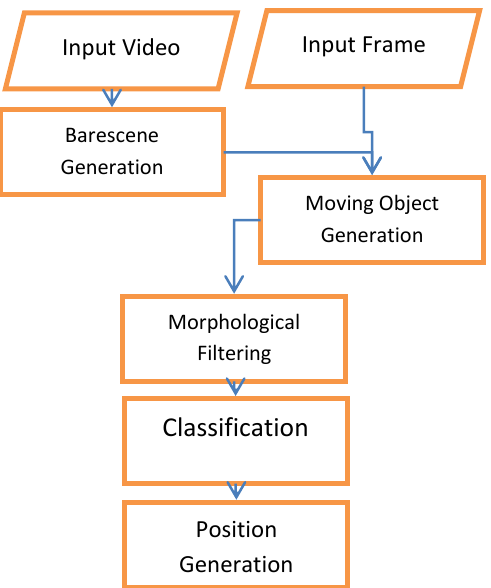
Figure 2: Flowchart of vehicle detection using image